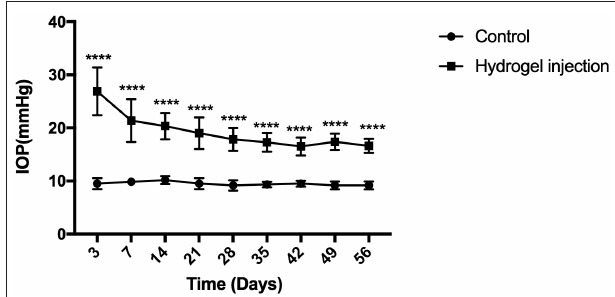
FIGURE 2 | Elevation of intraocular pressure (IOP) after intracameral injection of cross-linking hydrogel. The IOP of hydrogel injection eyes decreased slowly from the first measurement and then processed into a relatively stable phase of ocular hypertension for at least 8 weeks (average, 19.3 ± 4.1 mmHg). The control group presented a stable level of IOP throughout the whole period of the experiment (average, 9.5 ± 0.8 mmHg). There was statistical difference between the two groups ( p < 0.0001). Data were analyzed using two-tailed independent-samples t test followed by Bonferroni test (**** p < 0.0001, the group with injection of cross-linking hydrogel vs. the control group). N = 24 mice (control group: 6 mice; hydrogel injection group: 18 mice). Bars represent mean ± SD.